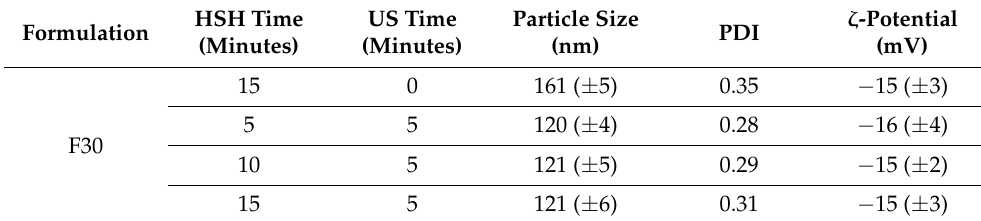
Table 2. Effect of HSH time on the formulation of blank F30 NLCs.